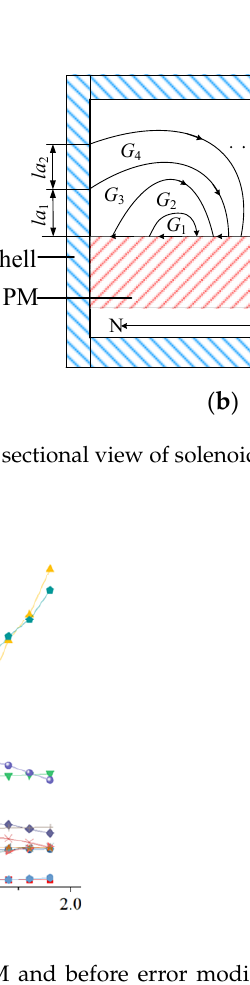
Figure 2. The leakage permeance of FEM and before error modifying the distributed parameter model. The FEM and DPM data are subtracted to obtain the MFL permeance error terms (i.e., G 1 , G 2 , G 3 , G 4 , G 5 , G 6 and G 7 ), which are then stored in the error matrix Er . The MFL permeance data are shown in Figure 3 which reveal a non-monotonic variation.